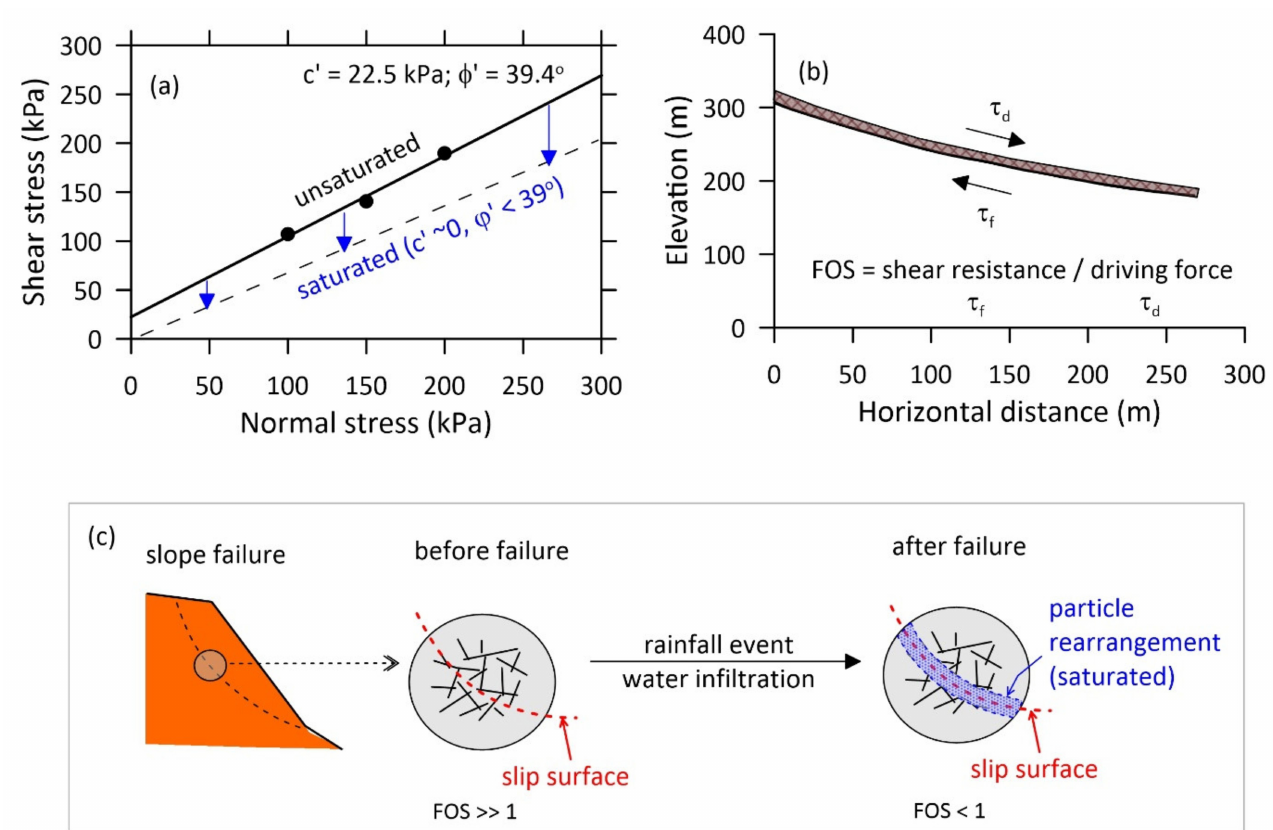
Figure 9. Determination of soil resistance for estimating the factor of safety for infinite slopes: ( a ) direct shear testing, ( b ) geomorphological profiles in shallow landslides, and ( c ) change in soil structure in slope